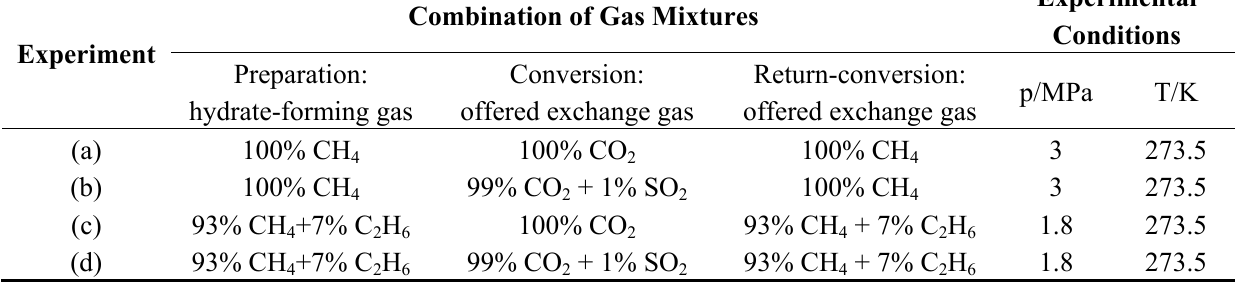
Table 2. List of performed experiments that shows the combination of used gas mixtures and respective p-T